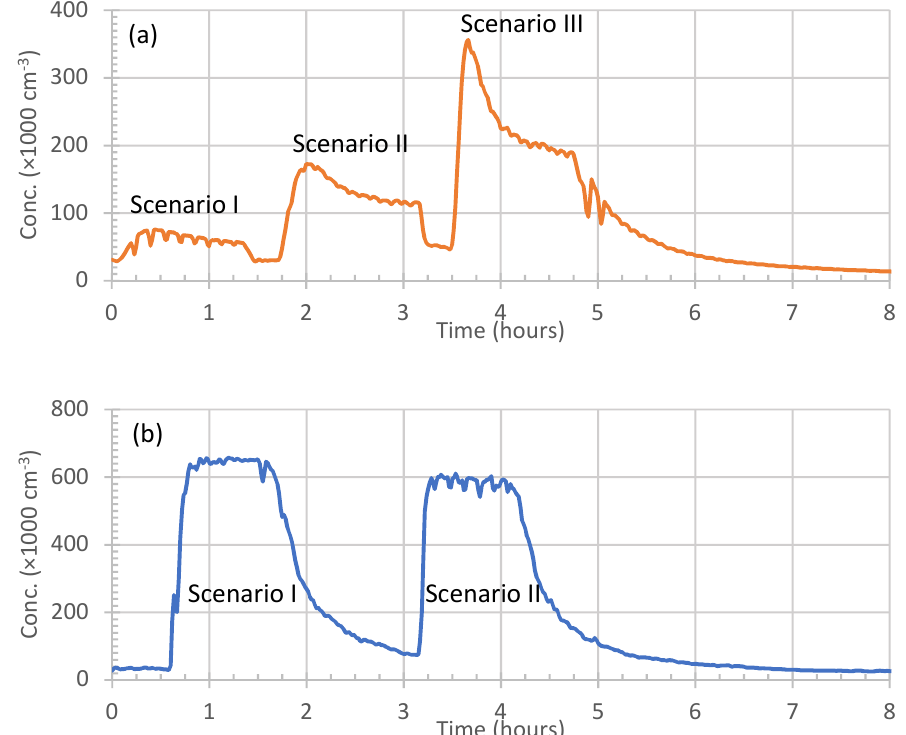
Figure 1. Measurement session examples reflecting the particle number concentrations observed during the operation of ( a ) natural gas heater scenarios and ( b ) kerosene heater scenarios. The scenarios are explained in Section 2.2 above.